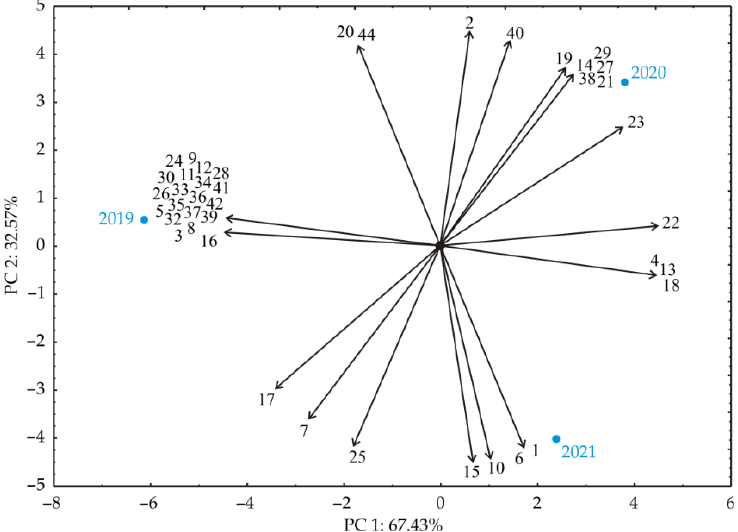
Figure 2. The PCA biplot diagram describing the relations between volatile compounds of Salvia officinalis essential oil.